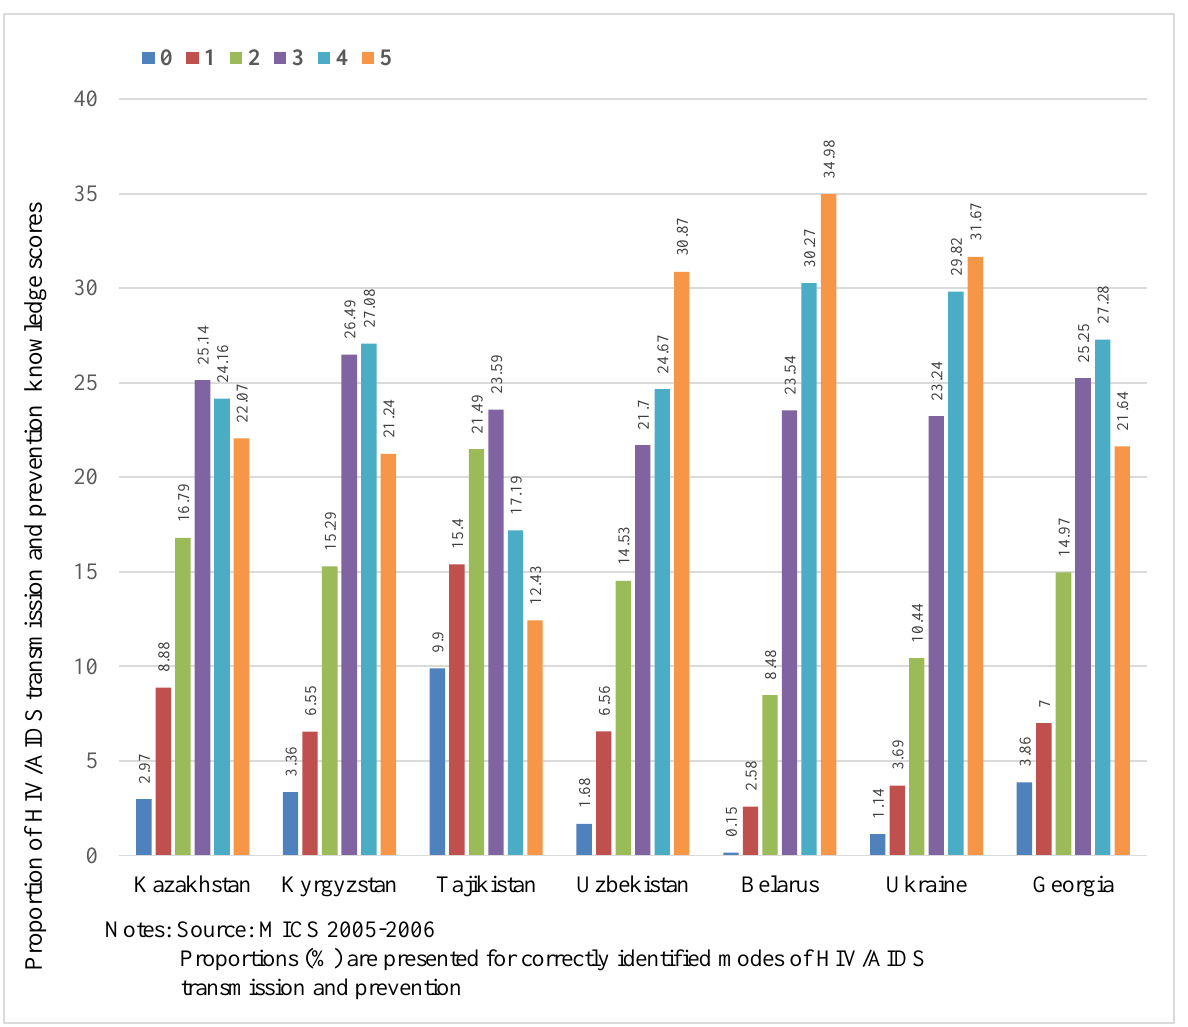
Figure 1. Distribution of scores for HIV/AIDS knowledge across seven compared countries. ran ordinary least squares (OLS) regression on the weighted data. To accurately assess the effect of age, which might not have a linear relationship with the outcome measure, we also included the age squared variable into our models. Data analyses were conducted using Stata 14 statistical software. Results